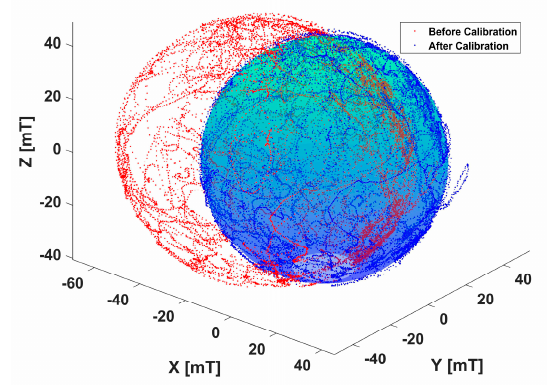
Figure 3. The calibration of magnetometer using the method of least squares.